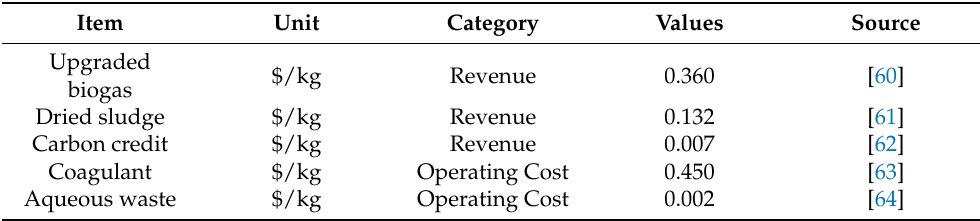
Table 11. Unit cost for products, raw materials and waste